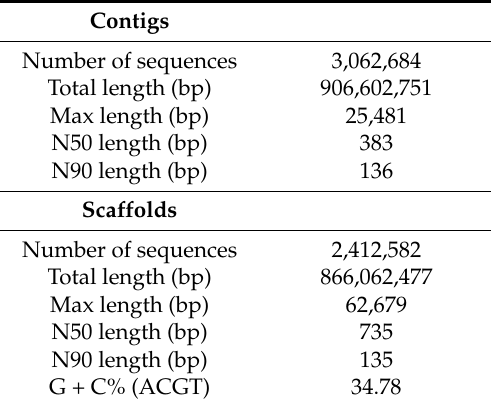
Table 1. Information of the assembled genome sequences of Acer truncatum .